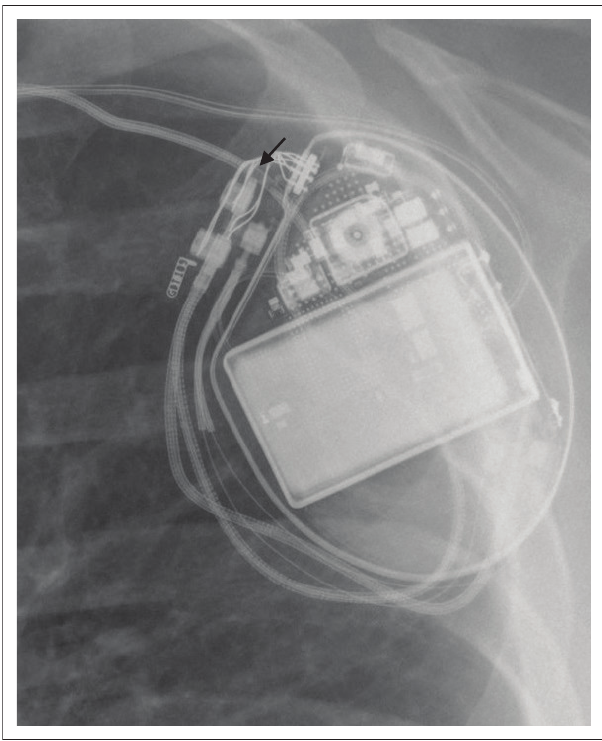
FIGURE 9: A dual-lead implantable cardioverter defibrillator with a subtle fracture (arrow) in the proximal portion of the right atrial lead, close to the generator.